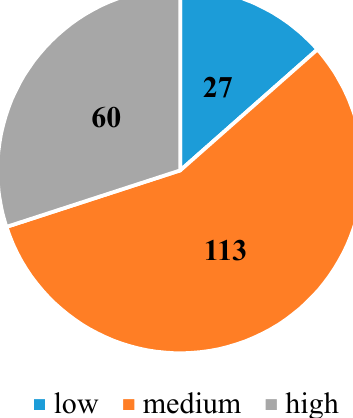
Figure 4. Damper positions in the analyzed refrigerators.